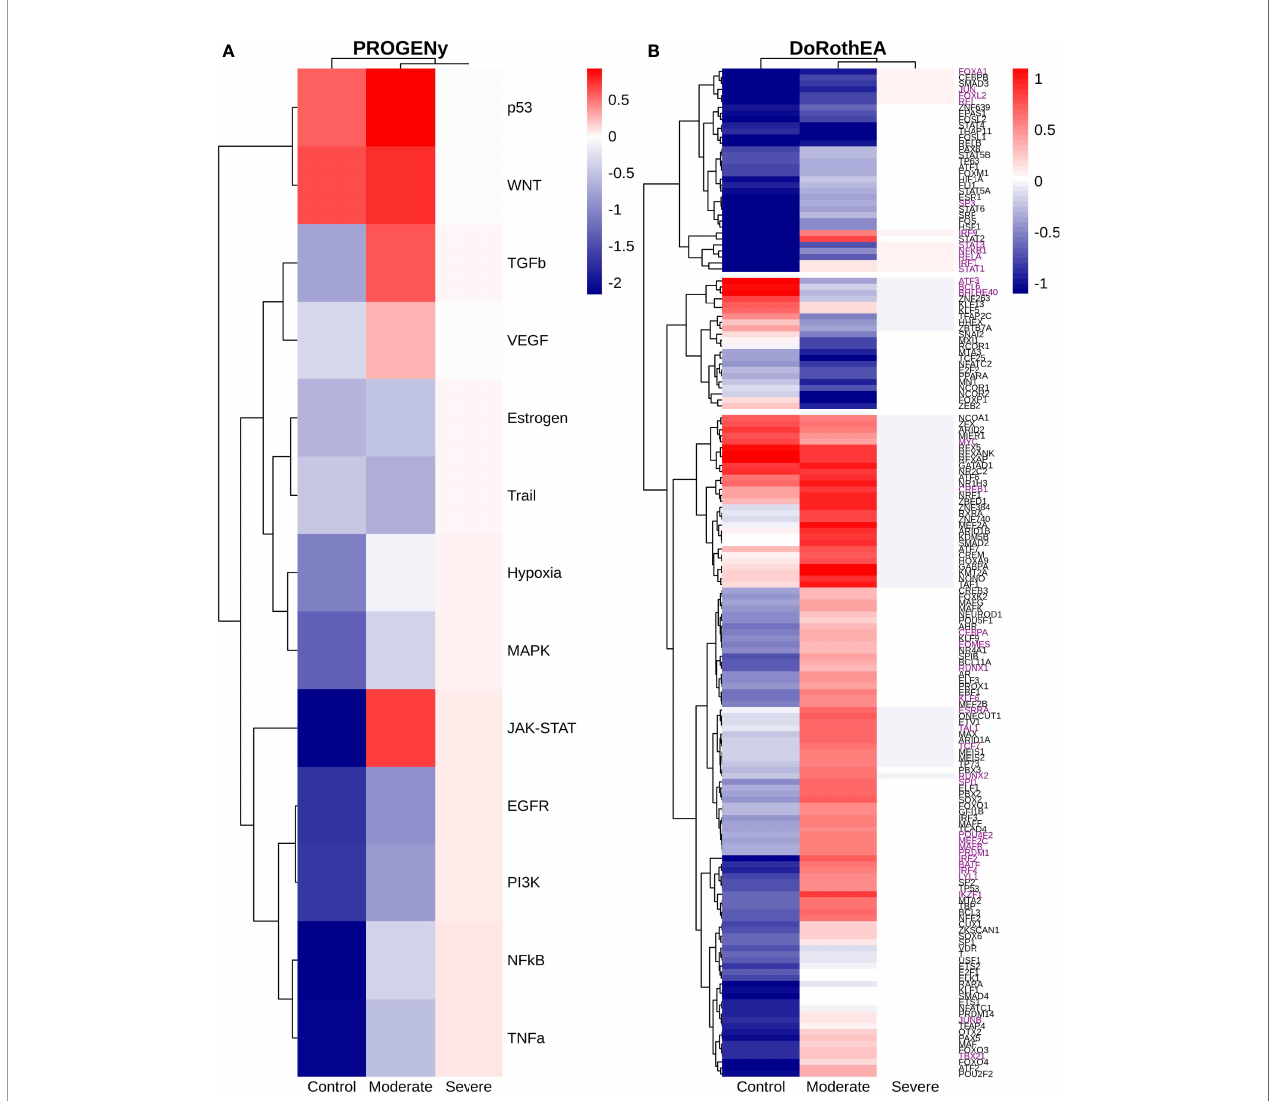
FIGURE 13 | TFs associated with the disease severity in neutrophils. (A) Resulting Heatmap from DoROthEA analysis. (B) Resulting Heatmap from PROGENy analysis. Colorbar sets the activation (red) and inactivation (blue)